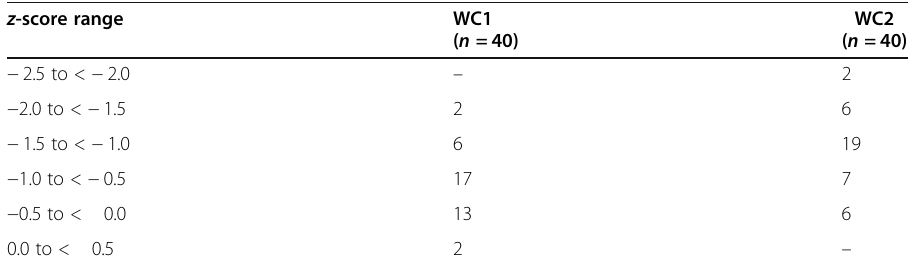
Table 5 The results of word concreteness analysis z -score